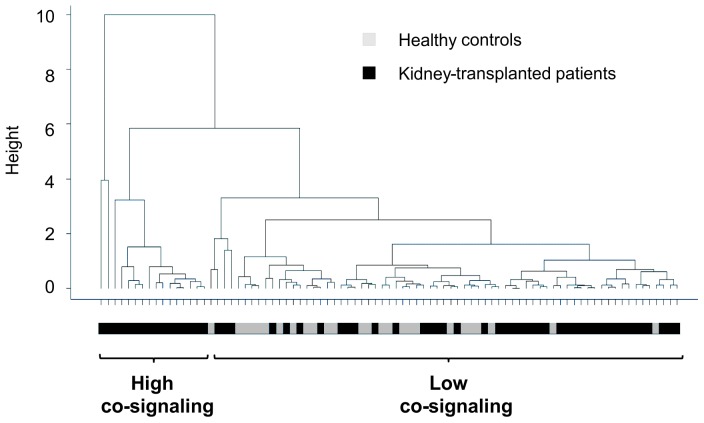
Clustering of patients by levels of co-signaling molecules.Unsupervised two-dimensional hierarchical clustering was used to group patients and healthy controls based on the principal components analysis (PCA) at 3 months post-transplantation. This analysis reduced the soluble molecule data to two principal components (PCs): the co-stimulatory (sCD30, sCD40, sCD137 and sCD40L) and the co-inhibitory (sPD-1 and sPD-L1). The dendrogram is derived from hierarchical clustering of all patients (n = 59) and healthy controls (n = 25) based on the PCs. Each line represents a single kidney-transplanted patient (black) or healthy control (gray). At 3 months post-transplantation, patients overlapping with healthy controls are characterized by low levels of co-stimulatory and co-inhibitory components (low co-signaling group), whilst patients grouped separately from controls are characterized by high levels of co-stimulatory and/or co-inhibitory components (high co-signaling group).